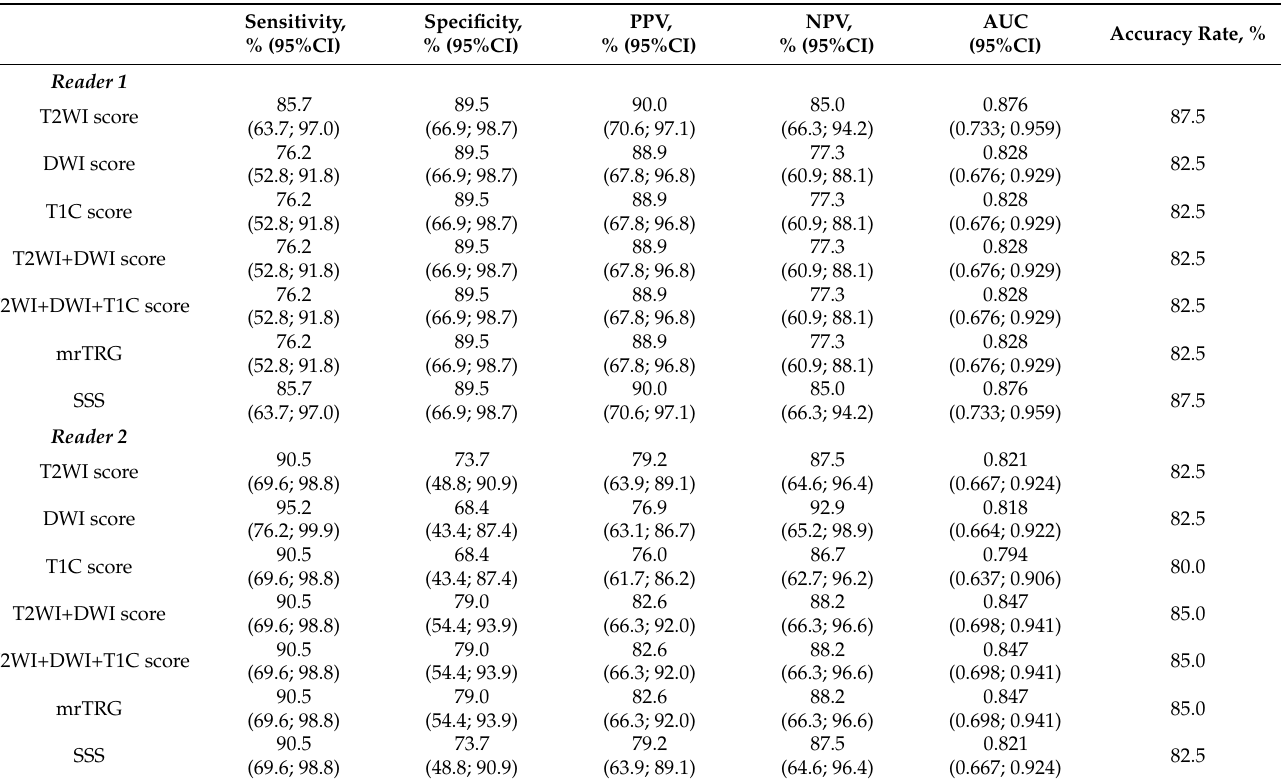
Table 5. Diagnostic performance of restaging MRI according to Reader to correctly identify a com- plete response.